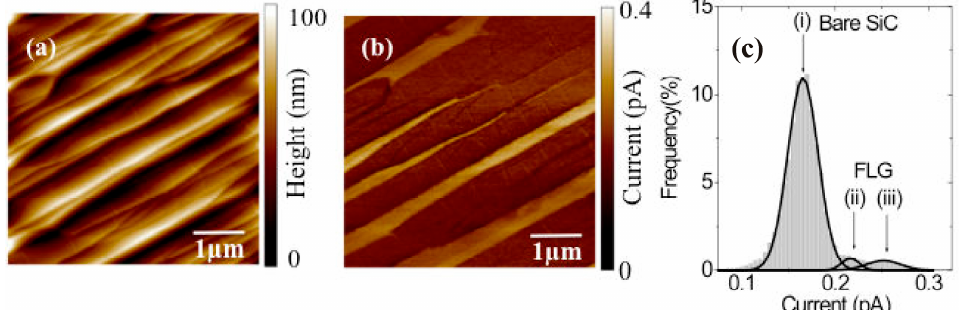
Figure 22. An AFM image ( a ) conductive atomic force microscopy map in ( b ). ( c ) Histograms extracted from the current map in ( b ). Three evaluated regions (region with graphene coverage (curves (ii) and (iii)) and region devoid of graphene (curve (i)) are indicated distinctly [124].